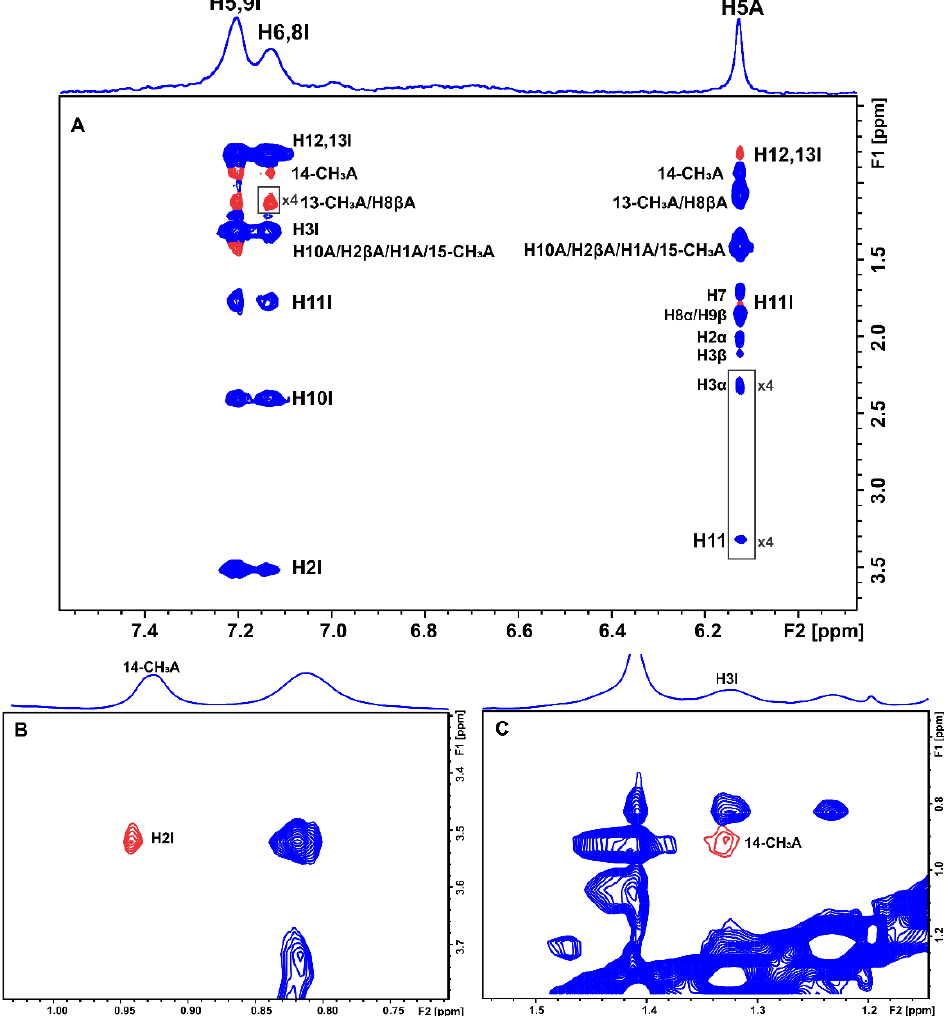
and 20 µ M BSA after the addition of 2 mM warfarin in PBS buffer solution in D 2 O, pD 7.4 with 10% DMSO-d 6 . ( A ) Red cross-peaks correspond to inter-NOEs between warfarin and artemisinin and ( B ) blue cross-peaks correspond to intra-NOEs of artemisinin. NMR parameters are the same as in Figure 3.